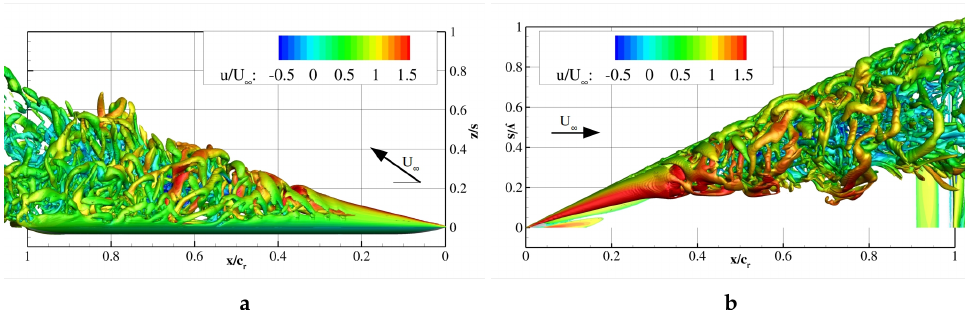
Figure 8. Computed Q-criterion Q = 10 5 s − 2 colored by the relative axial velocity; α = 35 ◦ , Re = 0.5 × 10 6 ; ( a ) side view and ( b ) top view.